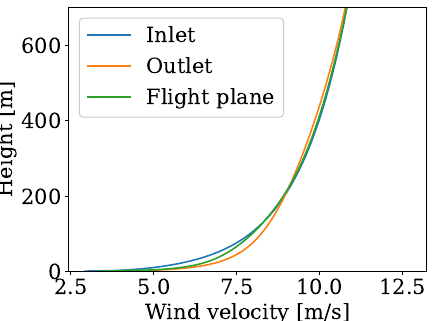
Figure 5. Resulting wind velocity profile at inlet, outlet and plane of flight.